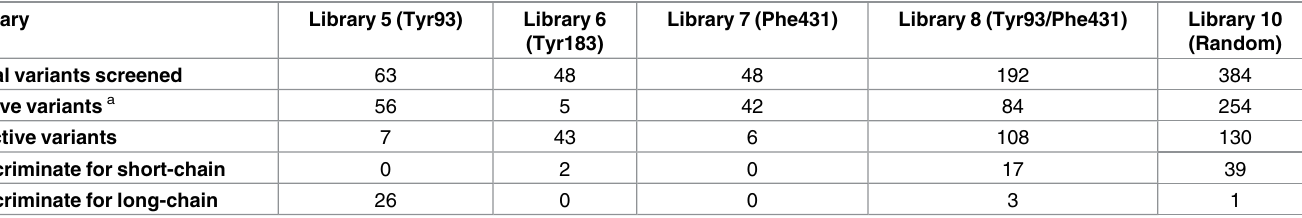
Discriminate for